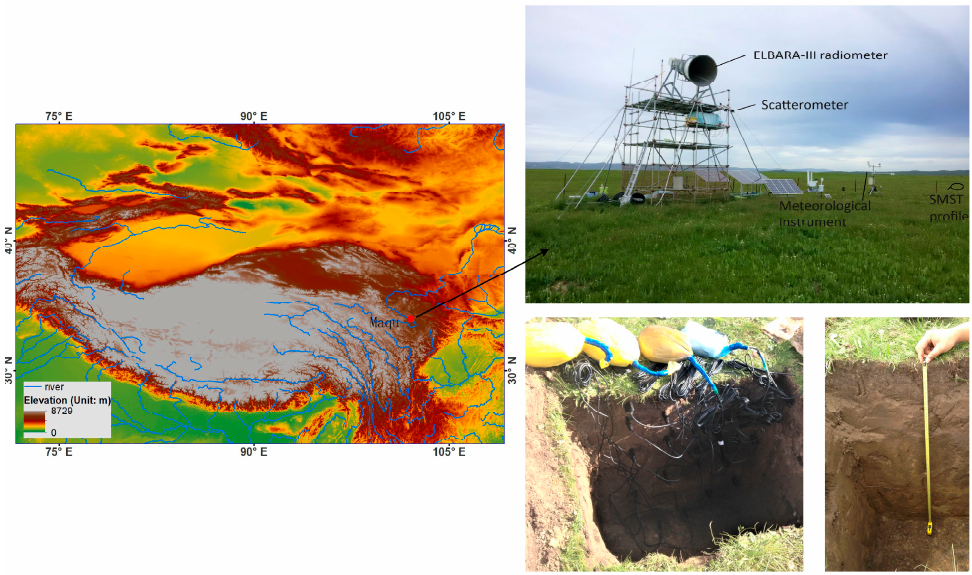
Figure 1. Location of the Maqu site on the northeastern Tibetan Plateau and the deployed measure- ments. The area of the ELBARA-III radiometer region is 25 m × 45 m [38].